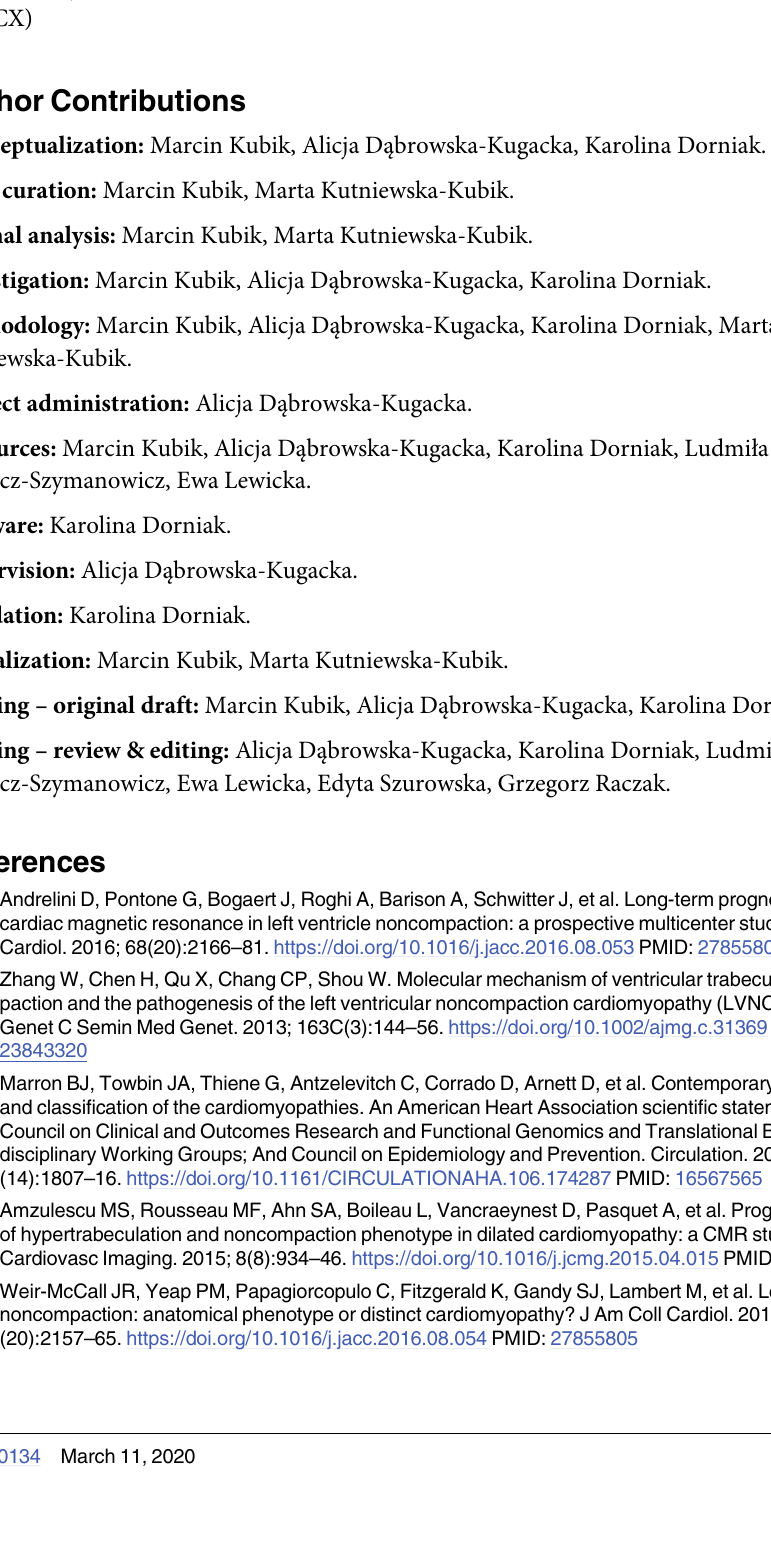
S2 Table. Regression analysis models. NCM